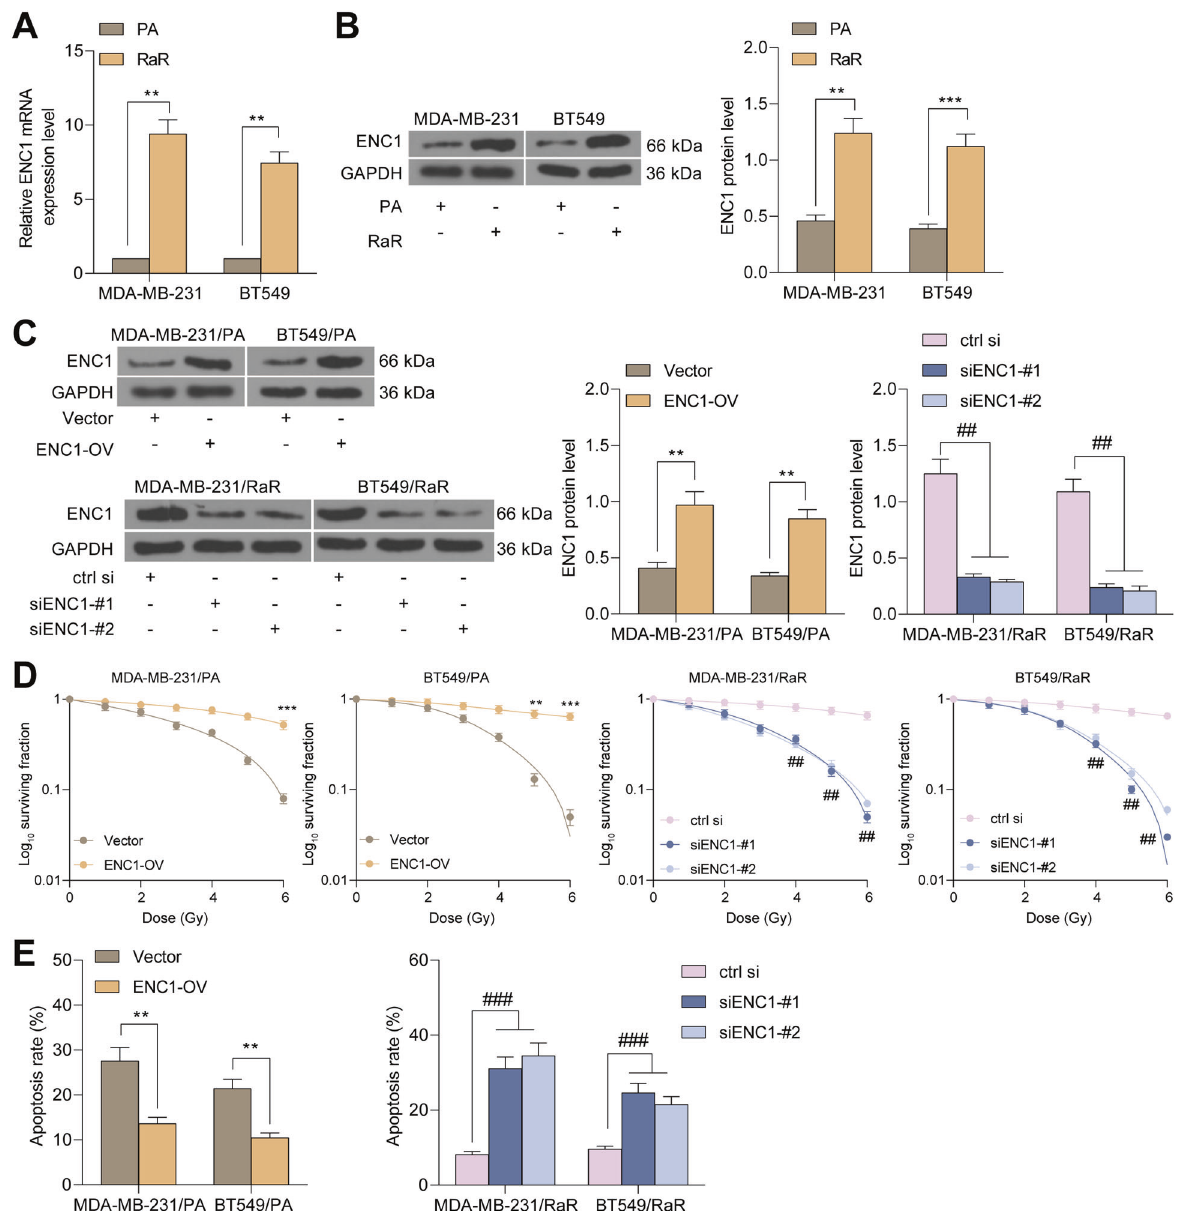
Fig. 2 ENC1 confers oncogenesis and radio-resistance to BC cells. A , B RT-qPCR ( A ) and western blot ( B ) detection of mRNA and protein expression of ENC1 in PA and RaR cells. ENC1 was overexpressed in PA cells and knocked-down in RaR cells. C Western blot detection of transfection ef fi ciency. D Cell viability of MDA-MB-231 and BT549 cells after 2 h of exposure to different doses of gamma radiations measured by colony formation assay. E Proportion of apoptotic cells detected by fl ow cytometry after irradiation of PA and RaR cells with 2 Gy doses of radiation. Data are representative of 3 separate experiments performed in triplicate. All the data are expressed as the mean ± SD. Two-way ANOVA with Tukey ’ s multiple comparison test were utilized to detect signi fi cant differences between data. ** p < 0.01, *** p < 0.001; ## p < 0.01; ### p <